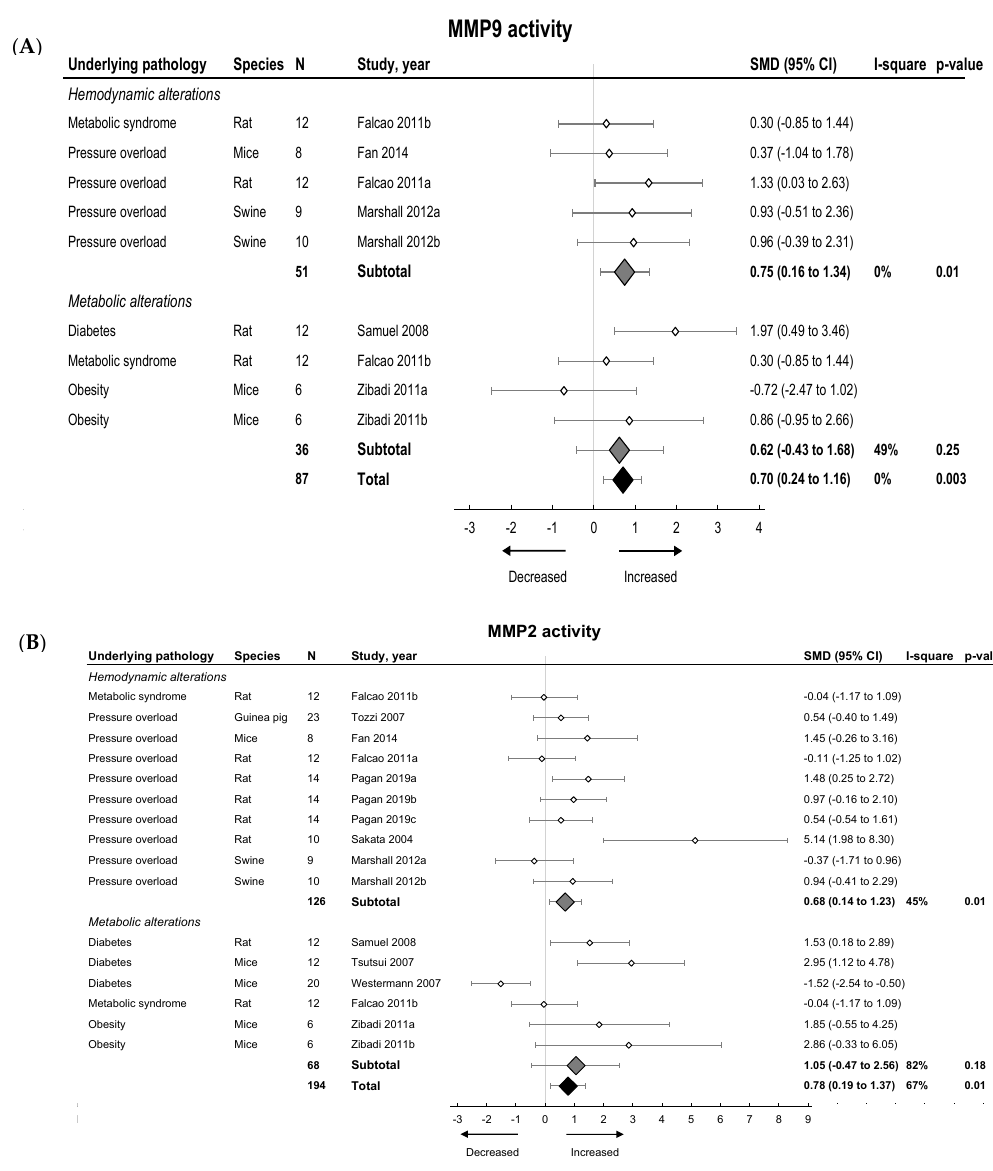
TIMP1, -2, -3, -4 were investigated. We found no pooled changes in MMP or TIMP expression in MMP2, -9, TIMP1 and -2 were subsequently analyzed. Pooled MMP2, TIMP1 and TIMP2 protein